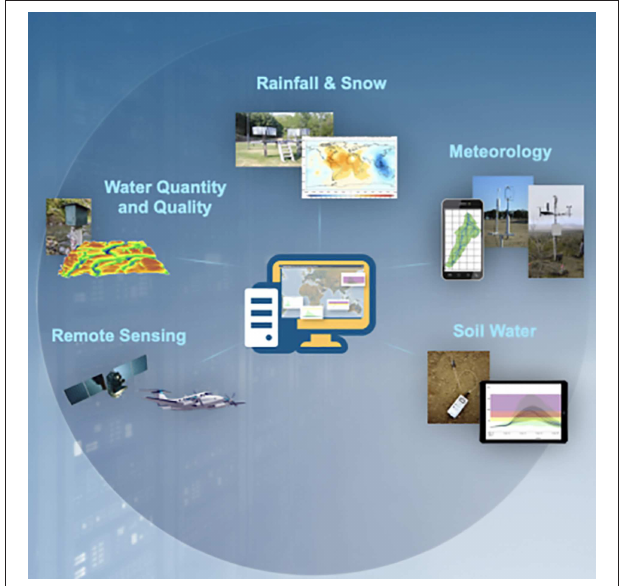
FIGURE 2 | Cyberinfrastructure requirements for hydrologic information